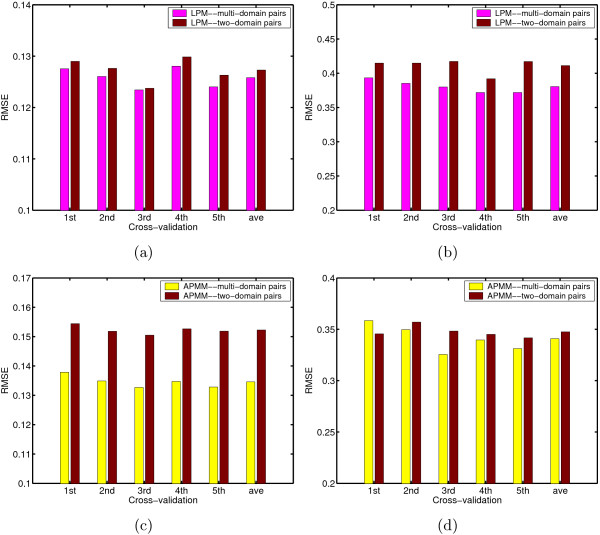
Comparisons of RMSE on two-domain pairs and on multiple-domain pairs for Krogan's yeast extended datasets. (a) The results of LPM on training. (b) The results of LPM on testing. (c) The results of APMM on training. (d) The results of APMM on testing.